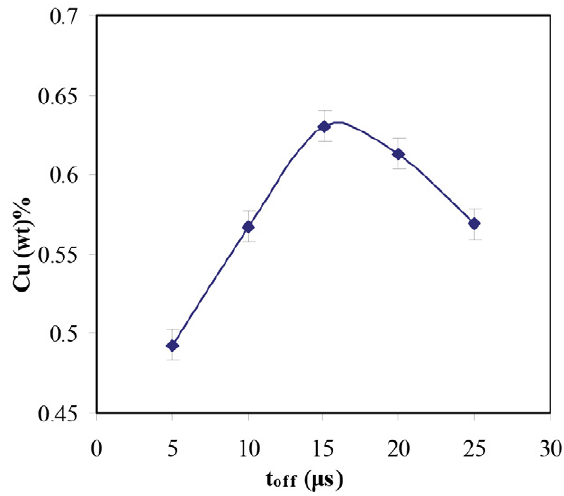
Figure 7. Diagram of diffused copper wt. % vs. t off .